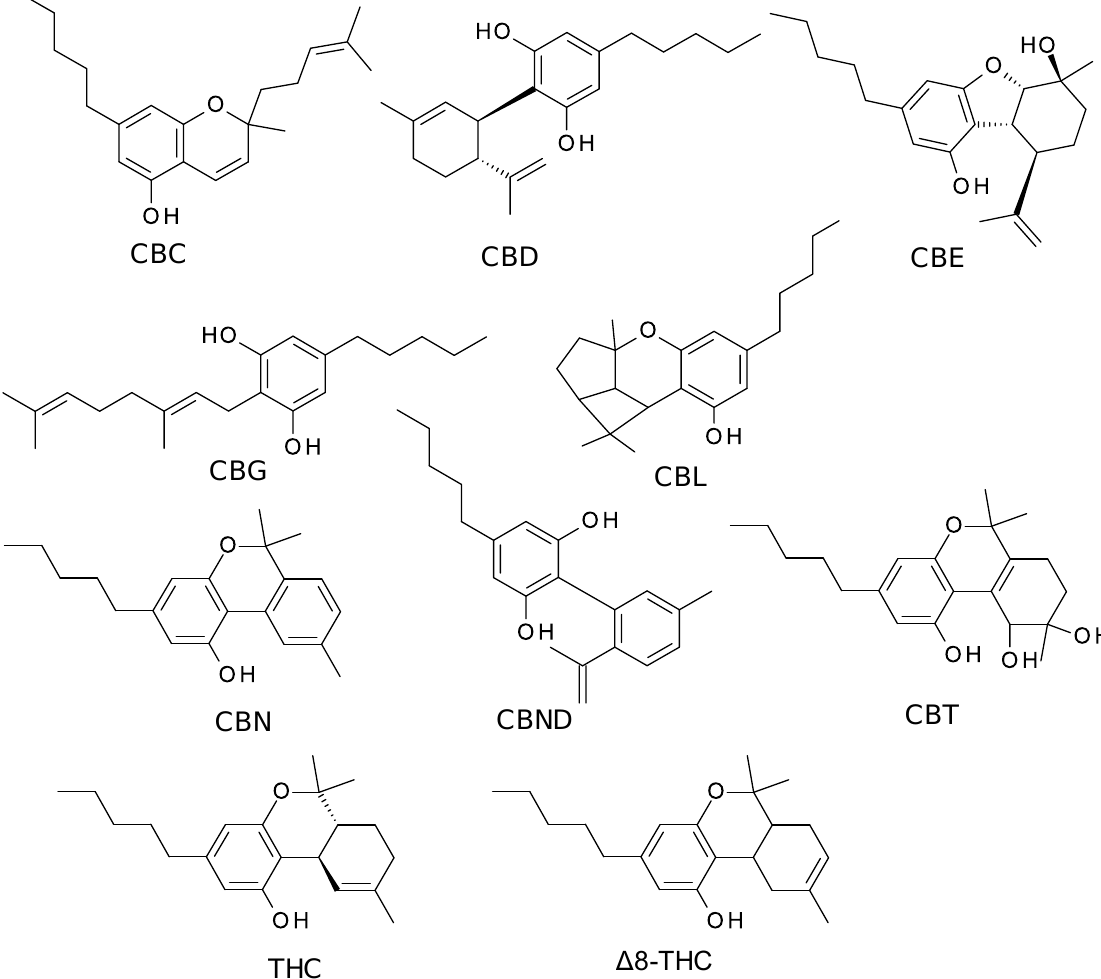
Figure 1 The structure of the most common phytocannabinoids [5]. Figure 1. The structure of the most common phytocannabinoids